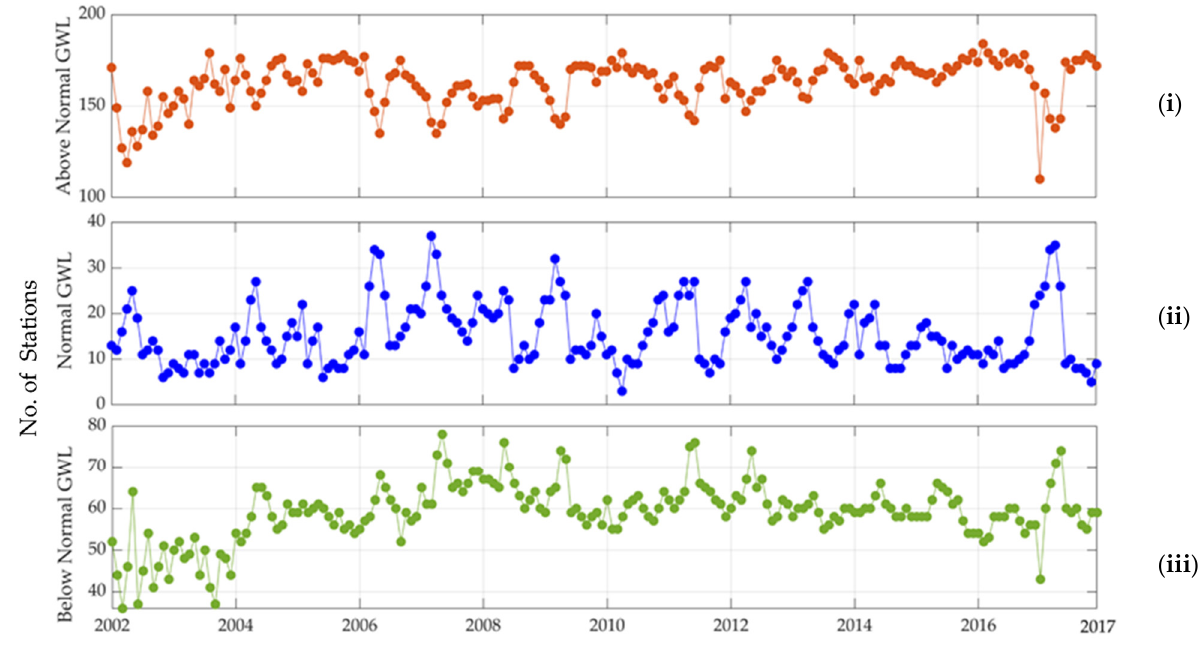
Figure 6. Frequency of stations under three categories: ( i ) Above Normal in red, ( ii ) Below Normal in green, and ( iii ) Normal in the blue line.